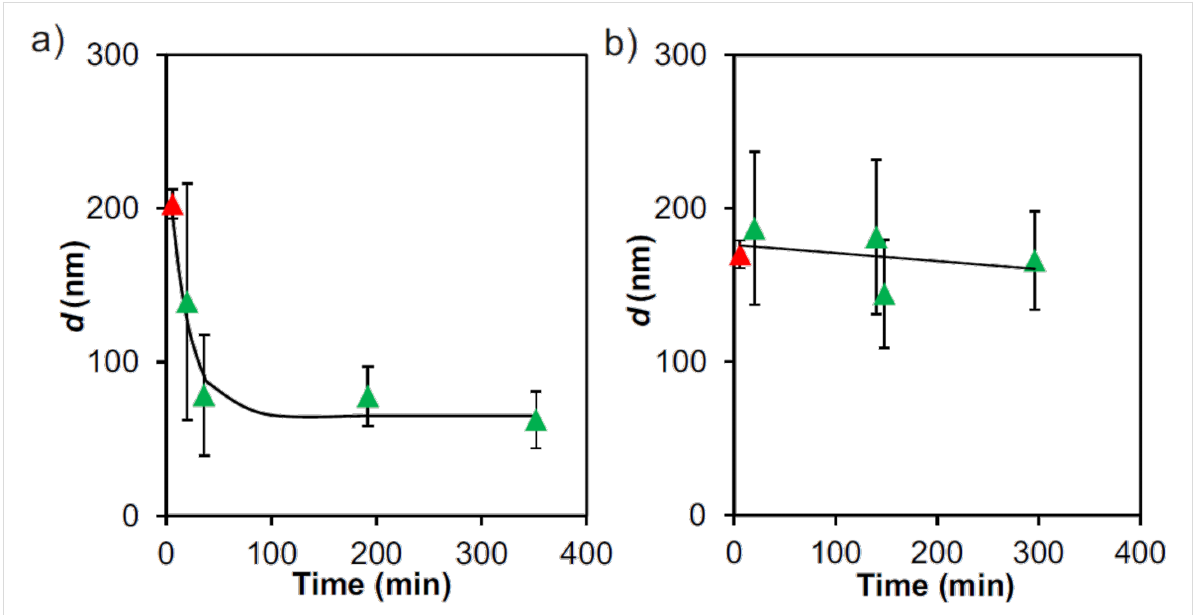
Figure 8: DLS size determination before (red) and after the addition of the oxidant agent Ce 4+ (green) for as-prepared SNPs: a) [CD] = 100 µM (in CD moieties from CD-PEI) [Fc] = 50 µM (in Fc moieties from Fc 8 -PAMAM) and [Ad] = 50 µM (from Ad-PEG) and b) [CD] = 100 µM and [Ad] = 37.5 µM (in Ad moieties from Ad 8 -PAMAM) and [Ad] = 62.5 µM (from Ad-PEG) (control) in 0.2 M NaCl. 10 equiv of Ce 4+ relative to Fc was added to the SNPs. Experimental d measurements (markers) and trendlines (line, guide to the